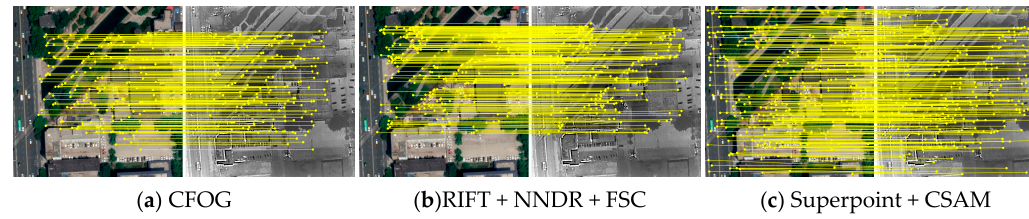
Figure 18. Optical–infrared matching results.